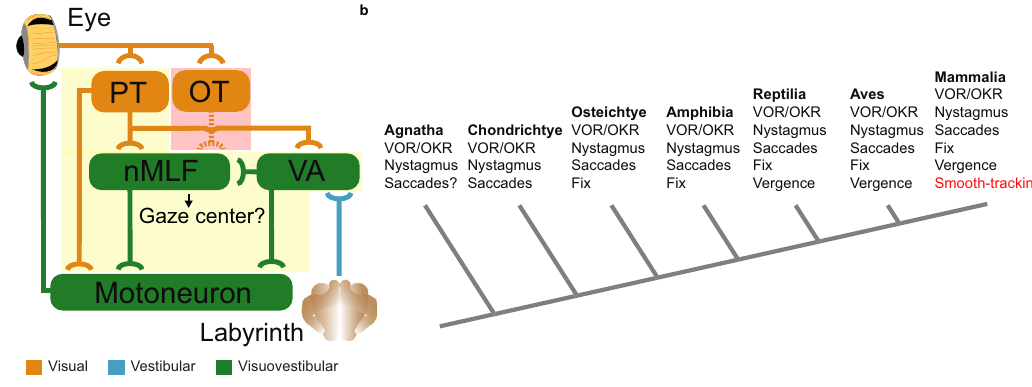
Fig. 10 | Subcortical pathways controlling gaze-stabilization. a A schematic showing the fl ow of visual (from the eye) and vestibular (from the labyrinth) informationwhenproducinggaze-stabilizingeyemovements(shadowedinyellow) andthelikelypathwayunderlyinggoal-orientedeyemovements(shadowedinred). Brain areas that process only visual information are highlighted in orange, vestib- ular in blue, and visuovestibular in green. Note that, as in mammals, visual infor- mationalreadyimpactsvestibularinputsassoonastheyenterthebrain,andthatall visuovestibular regions can be activated by visual or vestibular inputs indepen- dently. The motoneurons of the oculomotor nuclei initiate the VOR/OKR through